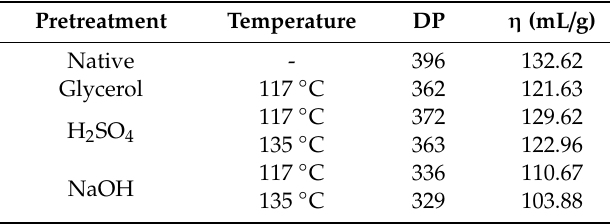
Table 2. Viscosity and degree of polymerization (DP) values of the bamboo samples with/without pretreatment.